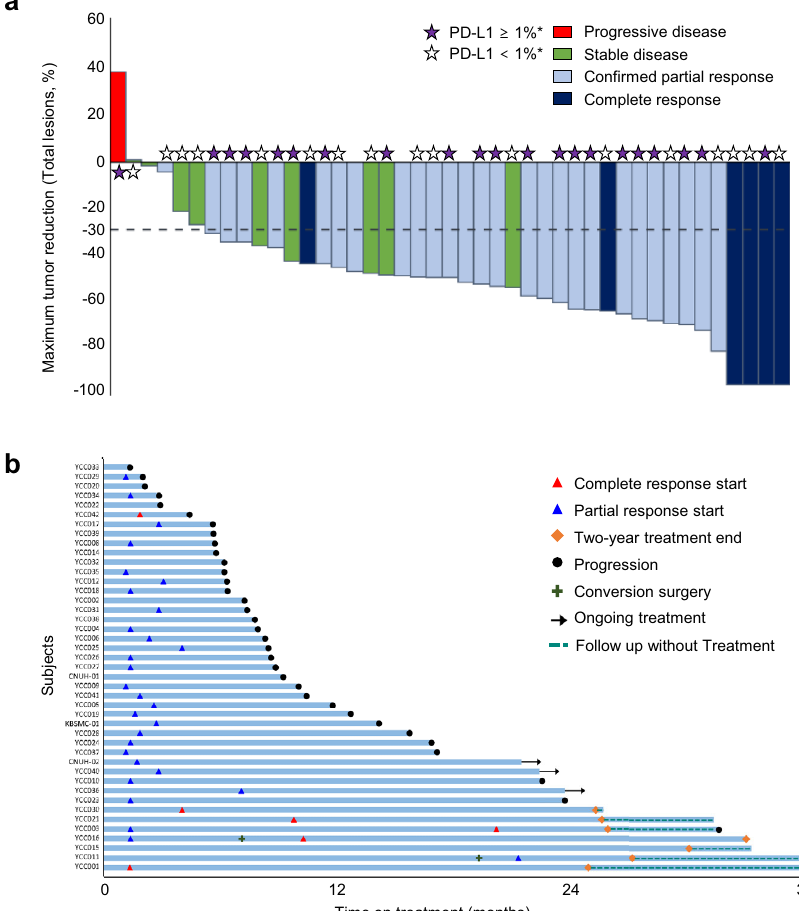
Fig. 2 | Tumor reduction in total lesions and tumor response. a Maximum percentage change from baseline in the size of total (target+non-target) tumor lesionswiththecorrespondingbestresponsesbasedonRECIST1.1criteriaandthe PD-L1 CPS from baseline tissue in all patients. The lower dotted line represents a 30% tumor reduction ( n =43). b A swimmer plot showing outcomes in all patients